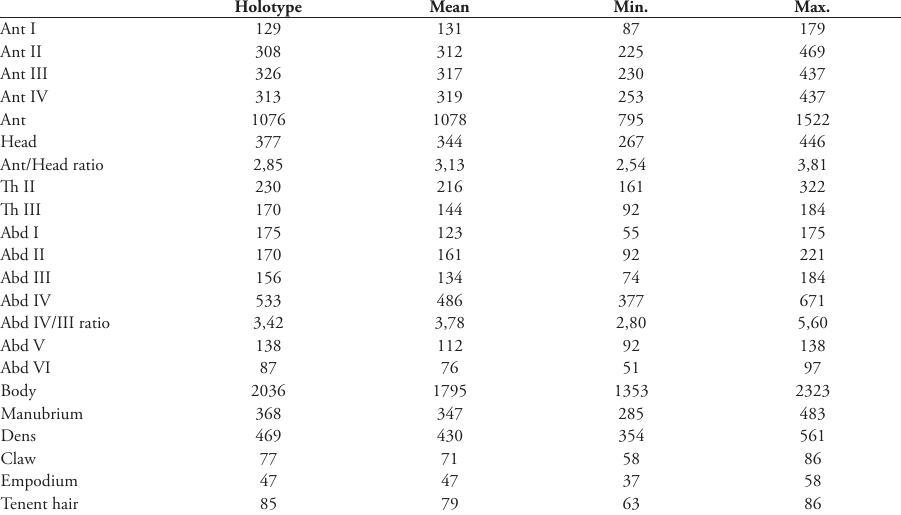
Table 1. Measurements of E. virginiae sp. nov. (in micrometers), average from 16 specimens. Holotype Mean Min. Max. Ant I 129 131 87 179 Ant II 312